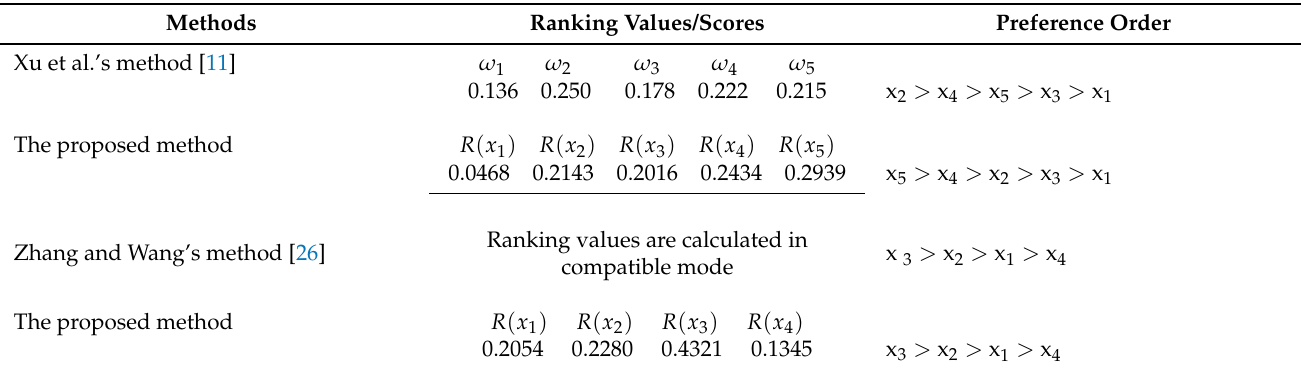
Table 1. Comparison of ranking of the